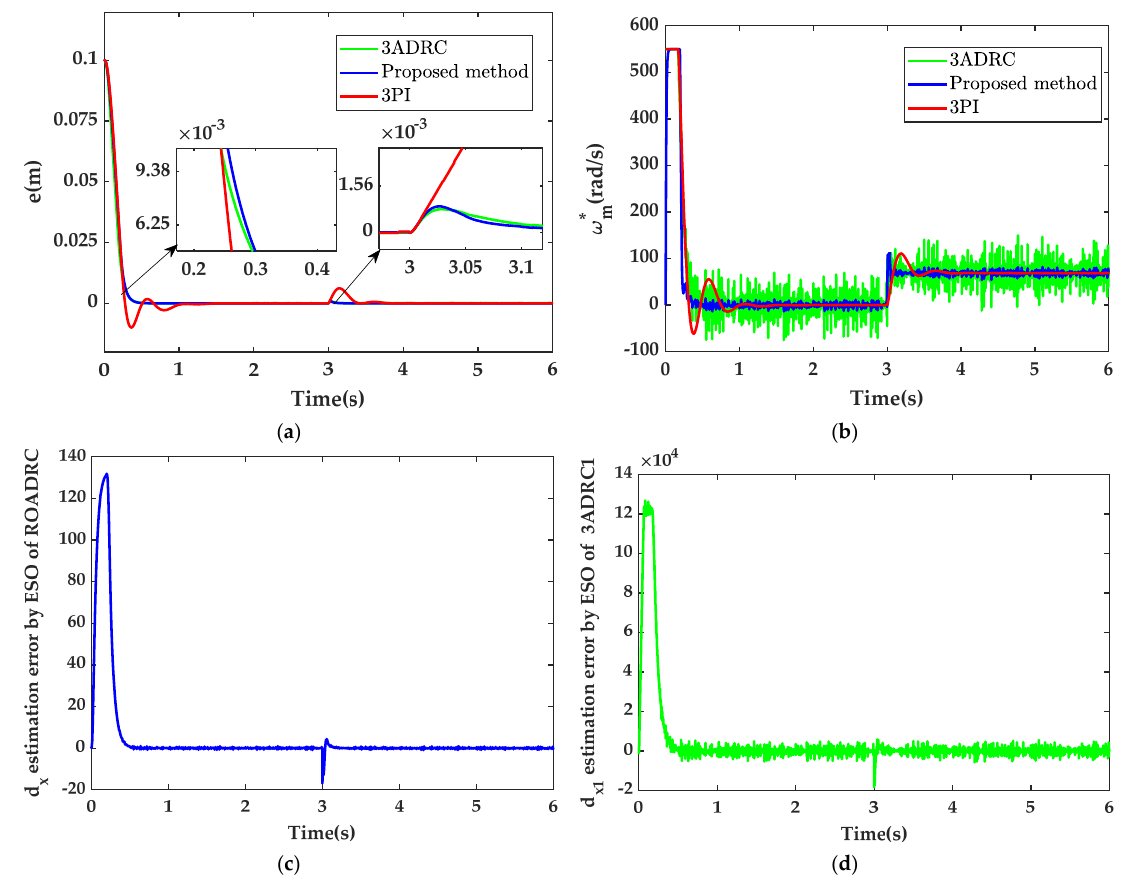
Figure 6. Position step response comparison curves with x d = 0.1m. ( a ) Comparison curves of position tracking errors of 3ADRC, the proposed method and 3PI; ( b ) control output ω m * response curves; ( c ) disturbance estimation error by ESO of ROADRC; and ( d ) disturbance estimation error by ESO of 3ADRC1.